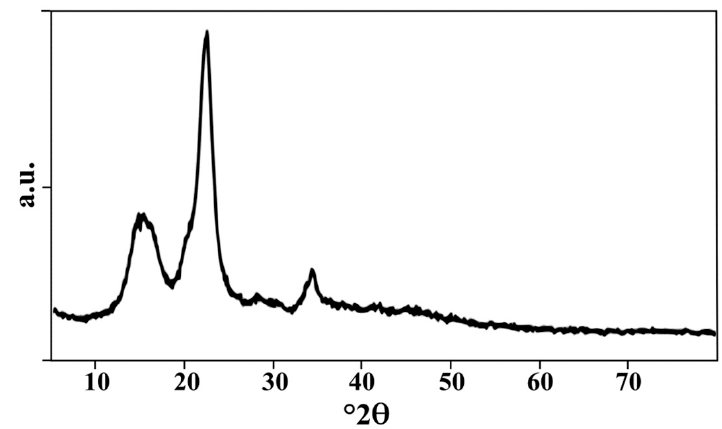
Figure 9. XRD analyses of microcrystalline cellulose.